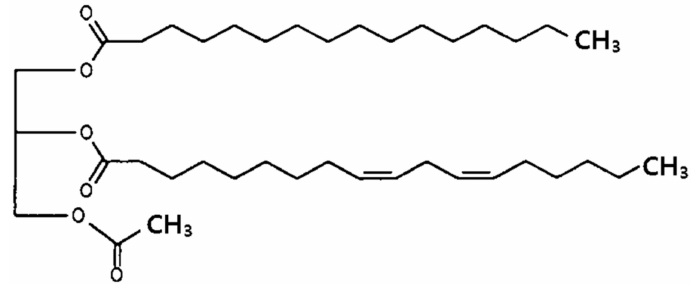
Figure 1. Structure of 1-palmitoyl-2-linoleoyl-3-acetyl-rac-glycerol